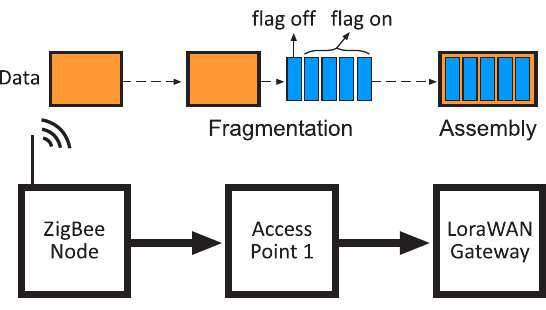
Figure 5. Fragmentation in a ZigBee-to-LoraWAN